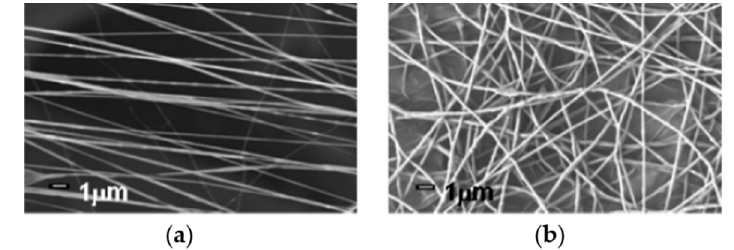
Figure 8. ( a ) SEM images of isotropic nanofibers and ( b ) anisotropic nanofibers [115] (Copyright 2007, American Chemical